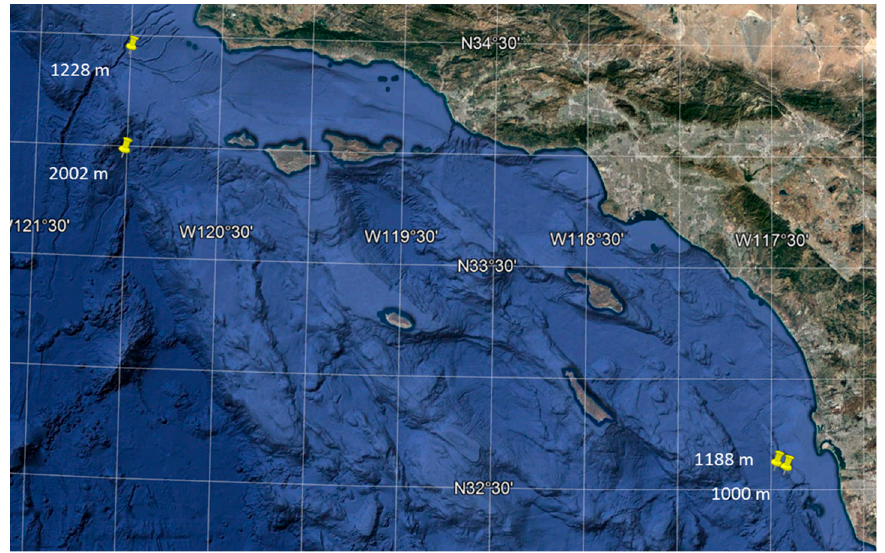
Figure 11. Field sample sites for laboratory measurements (Google Earth).